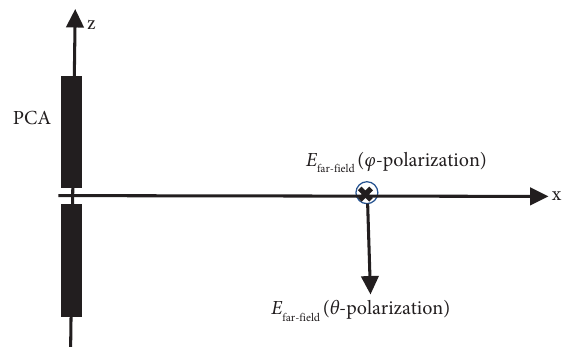
Figure 10: COMSOL calculation in the far-feld at θ � 90 ° showing the theta- and phi-polarizations (equivalent to horizontal H and vertical V polarizations in the experiment). Table 1: COMSOL far-feld results at θ � π /2 and φ � 0 and f � 2THz. Bowtie Slotted Fractal Circular